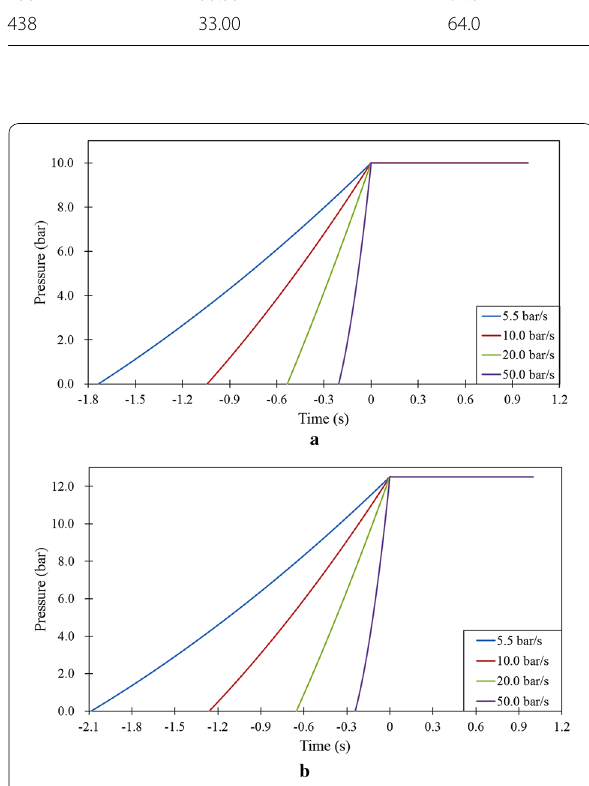
Fig. 2 Pressure profiles with time until a 10 and b 12.5 bar with pres‑ sure variation rate of 5.5, 10, 20, 50 bar/s